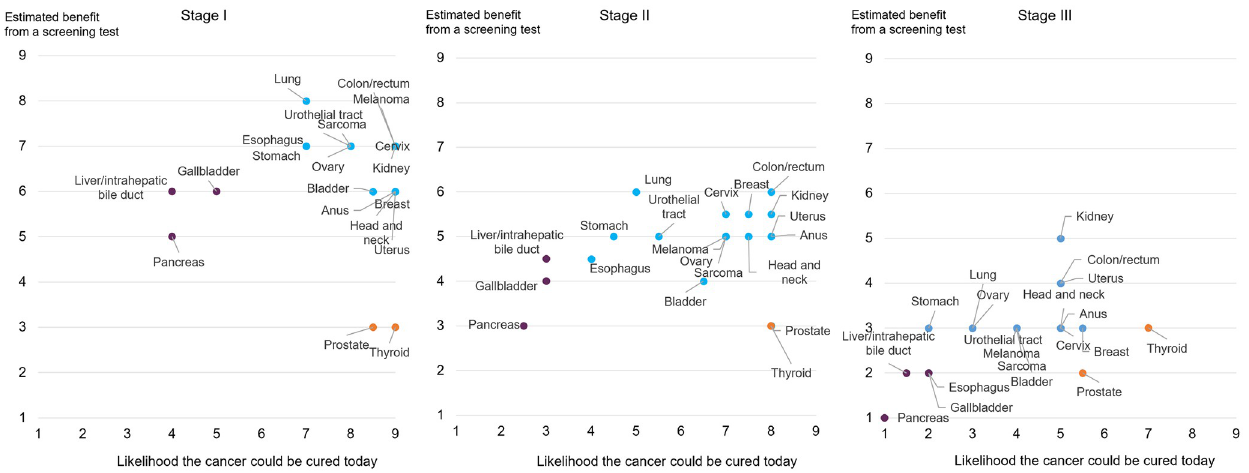
Fig 1. Ratings of cancer curability today and the estimated benefit from a hypothetical screening blood test. The x-axis represents expert ratings on how likely they believe a cancer could be “cured” today, defined as the receipt of effective treatment such that a population of individuals who are “cured” would have the same life expectancy as a population that never had the cancer being considered. Curability was rated on a scale of 1 (extremely unlikely to be cured) to 9 (extremely likely to be cured). The y-axis represents expert ratings on the estimated benefit from a hypothetical screening test, defined as the improvement in curability as a result of the test. Improvement in cure was rated on a scale of 1 (not at all likely to increase) to 9 (increase a great deal). Cancers in blue are those experts believed could potentially benefit the most from a hypothetical screening test (those with high curability today in earlier stages and likely to progress). Experts believed cancers in purple may show some benefit from a hypothetical screening test (lower curability today in earlier stages and likely to progress). Cancers in orange were rated as least likely to benefit from a hypothetical screening test (high curability in earlier stages today and progress slowly).